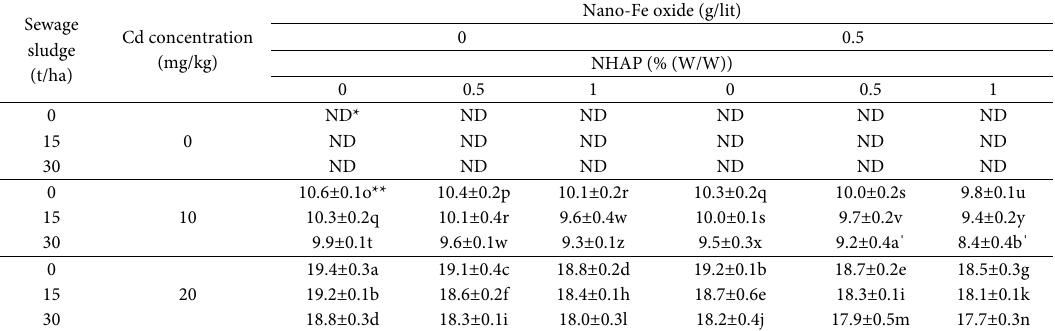
Table 2. Effect of foliar application of Nano-Fe oxide, NHAP, and Cd- polluted sewage sludge on soil Cd concentration